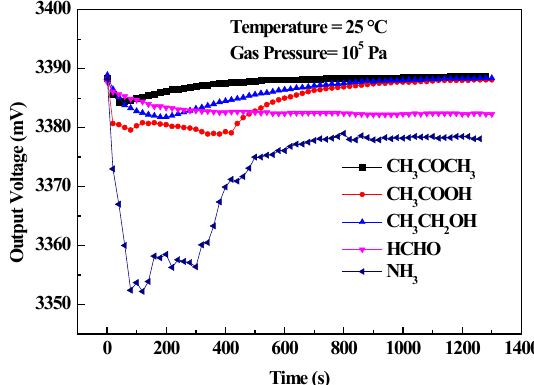
Figure 6. The response of the platform to the gases with different thermal conductivities, including ethanol, acetic acid, acetone, ammonia, and formaldehyde mixed with air at atmosphere pressure, in 25 °C, respectively.